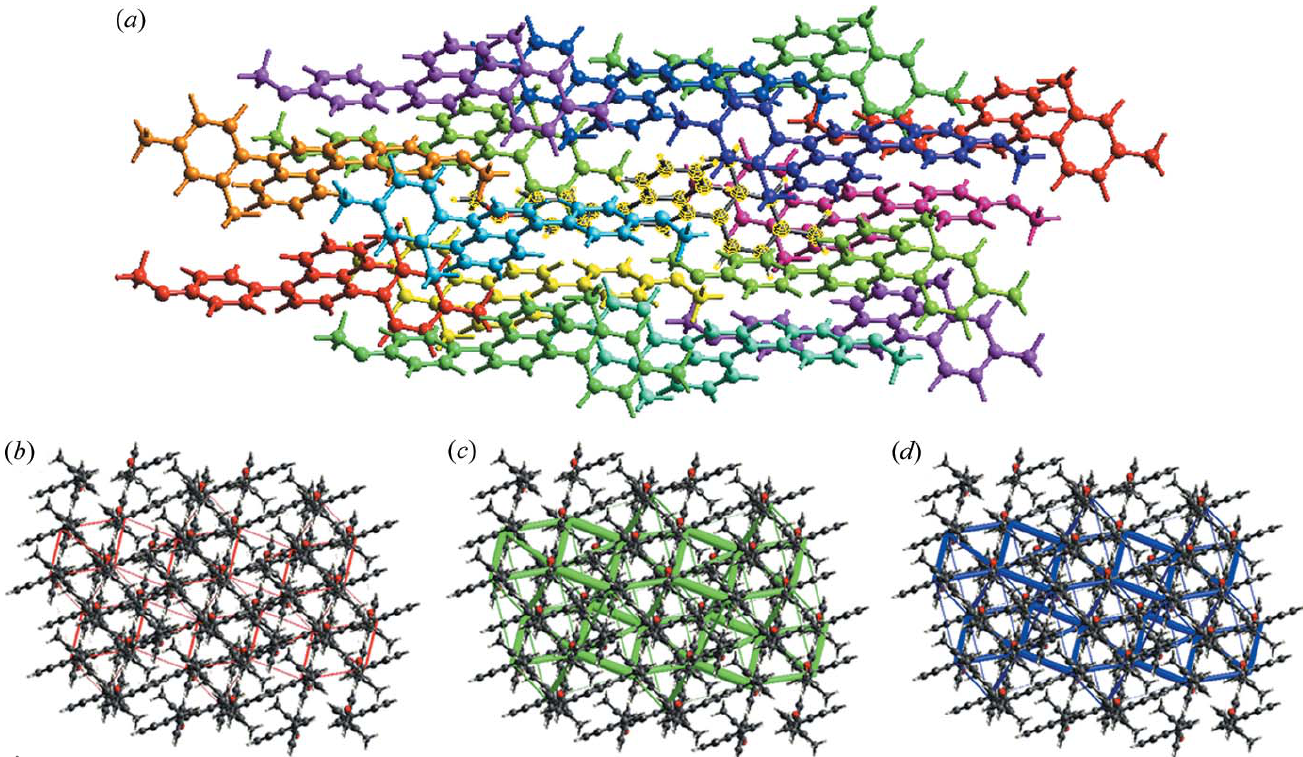
Figure 5 ( a ) Interaction between the selected molecule and the molecules present in a 3.8 A˚ cluster around it, ( b ) Coulombic energy, ( c ) dispersion energy and ( d ) total